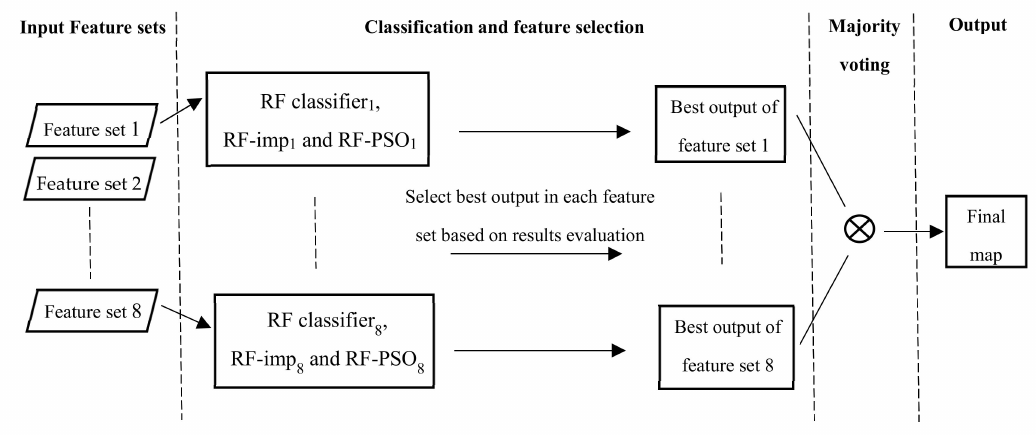
Figure 4. Flowchart of the classification-feature selection ensemble procedure. RF-imp and RF-PSO are feature selection methods, random forest (RF), RF-variable importance measure (RF-imp), RF-particle swarm optimization (RF-PSO), and the numbers 1–8 refer to the number of feature